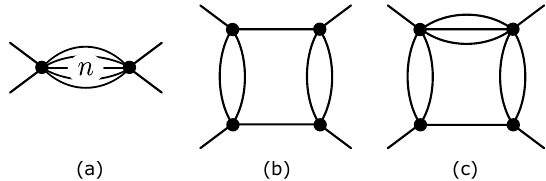
Figure 2: A few simplest examples of graphs that represent various singularities of the 2 → 2 scattering amplitude. a) The bubble diagram represents multi-particle normal thresholds. b) The two-particle box diagram. It represents a Landau curve along which the scattering amplitude develops double discontinuity. c) The four- particle box diagram. This diagram corresponds to four-particle scattering both in the s - and in the t -channel. In this paper we systematically study the graphs of this type and the corresponding Landau